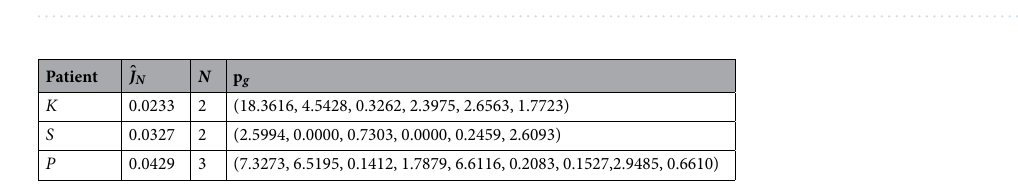
Figure 2. Graphs of functions approximating the clinical data of patients ( K —circles, S —squares, P — rhombi): pressure p 2 at the AVM output and blood flow q b at the AVM input, depending on the average blood ¯ S . concentration in the AVM